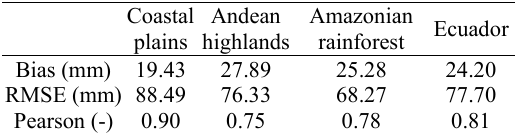
Table 2. Average bias, RMSE and Pearson correlation